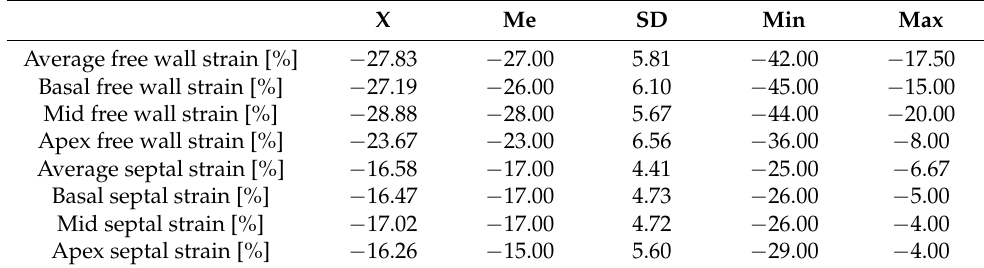
Table 4. Right ventricular strain parameters in the study group.